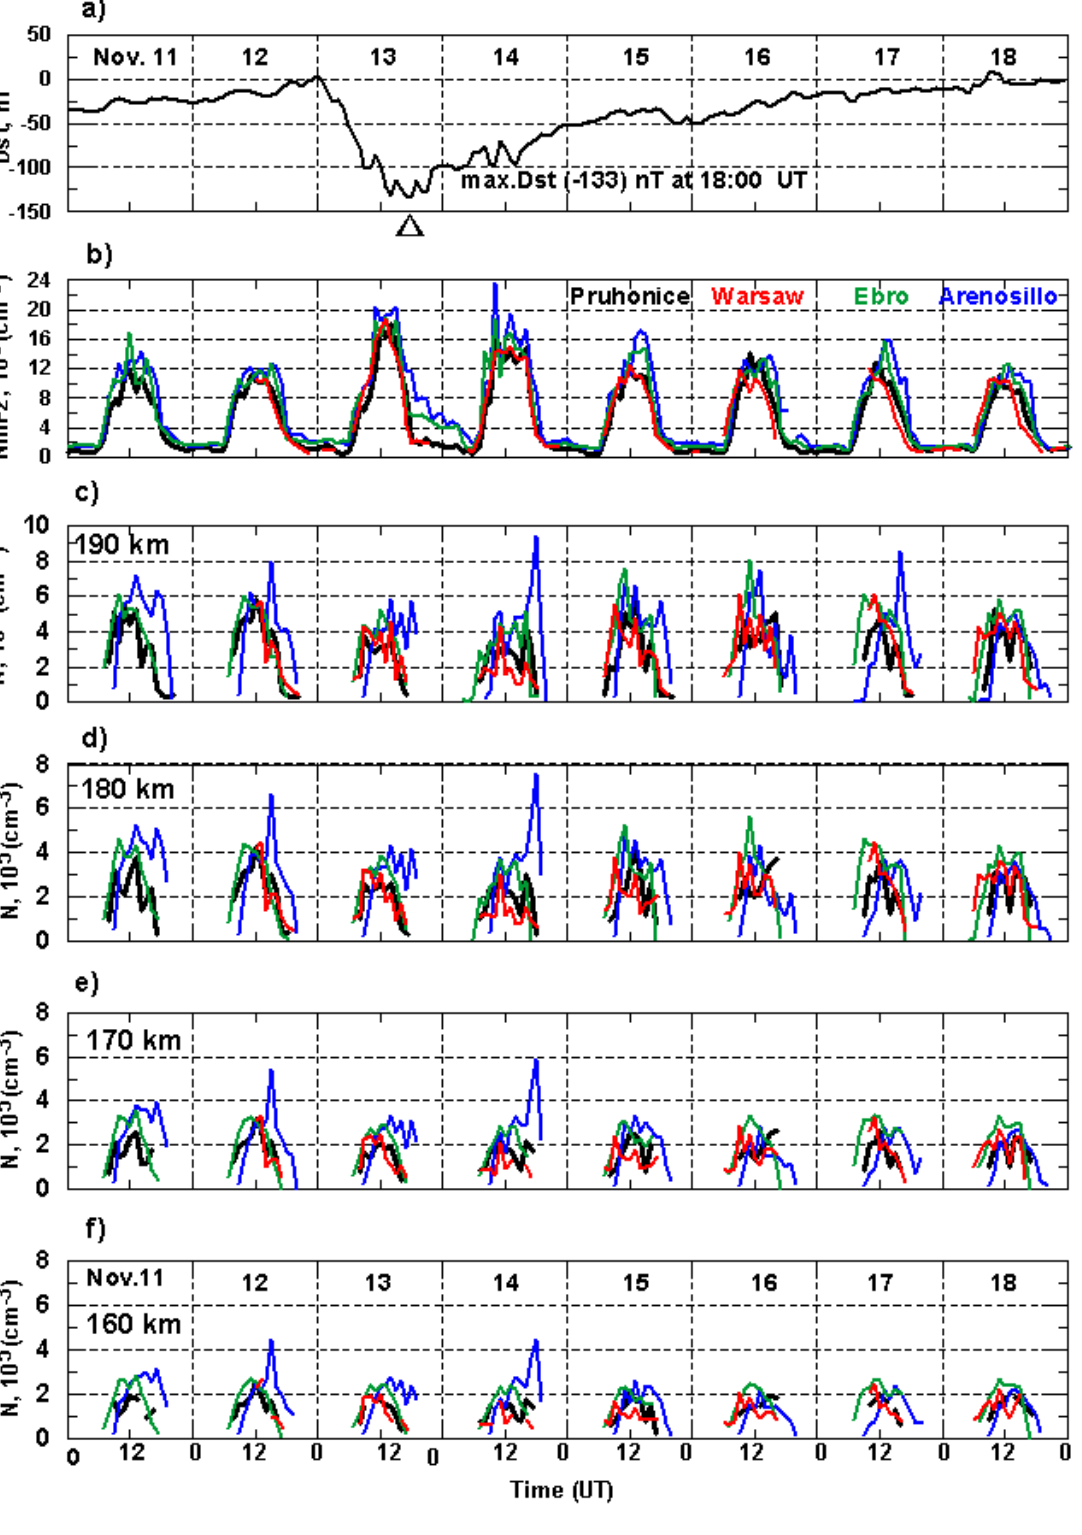
Fig. 2. Storm of November 1998: (a) hourly D st indices, (b) hourly Nm F2 values for Pruhonice, Warsaw, Ebro and Arenosillo, (c–f) electron density at 190, 180, 170 and 160km, respectively, for daytime hours for all stations. Time is in